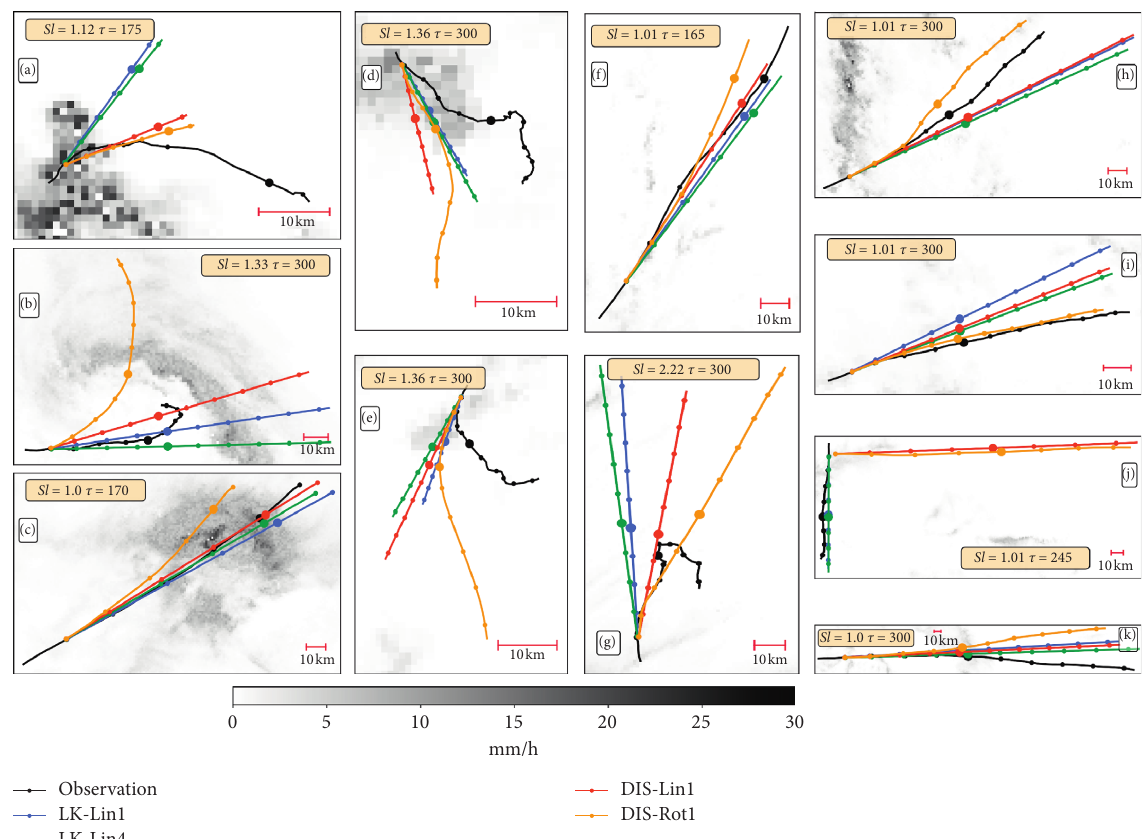
Figure 7: Compilation of forecast versus observed tracks under different sinuosity conditions. Due to the different spatial extents of the windows, the scale of each subplot is different. Hence, a 10km scale bar is provided for orientation. For each example, the observed track duration τ (in hours) and its sinuosity index SI are shown. The lead time of 120 minutes is highlighted by a larger dot. Some very long tracks have been capped at a maximum of 300 minutes for illustrative